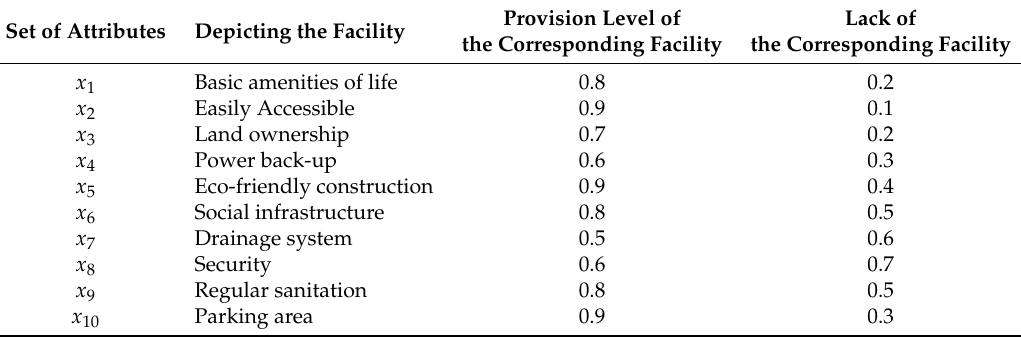
Table 6. Description of